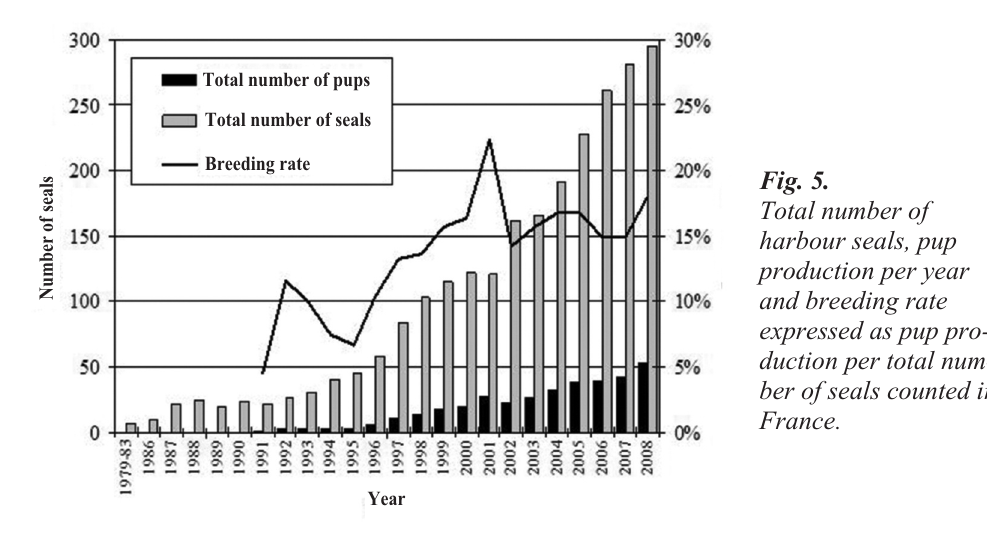
Fig. 5. Total number of harbour seals, pup production per year and breeding rate expressed as pup pro- duction per total num- ber of seals counted